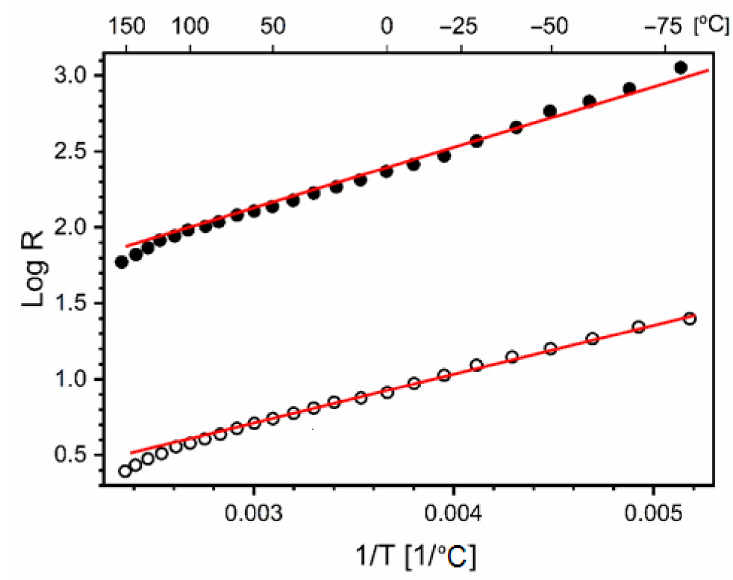
Figure 4. Logarithm of experimentally determined resistances as a function of the inverse of tem- perature, open circle–CNT coating, full circle CNT/PS coating. In these coordinates, the slope of the straight line segment of the graph corresponds to the α exponent value from Equation